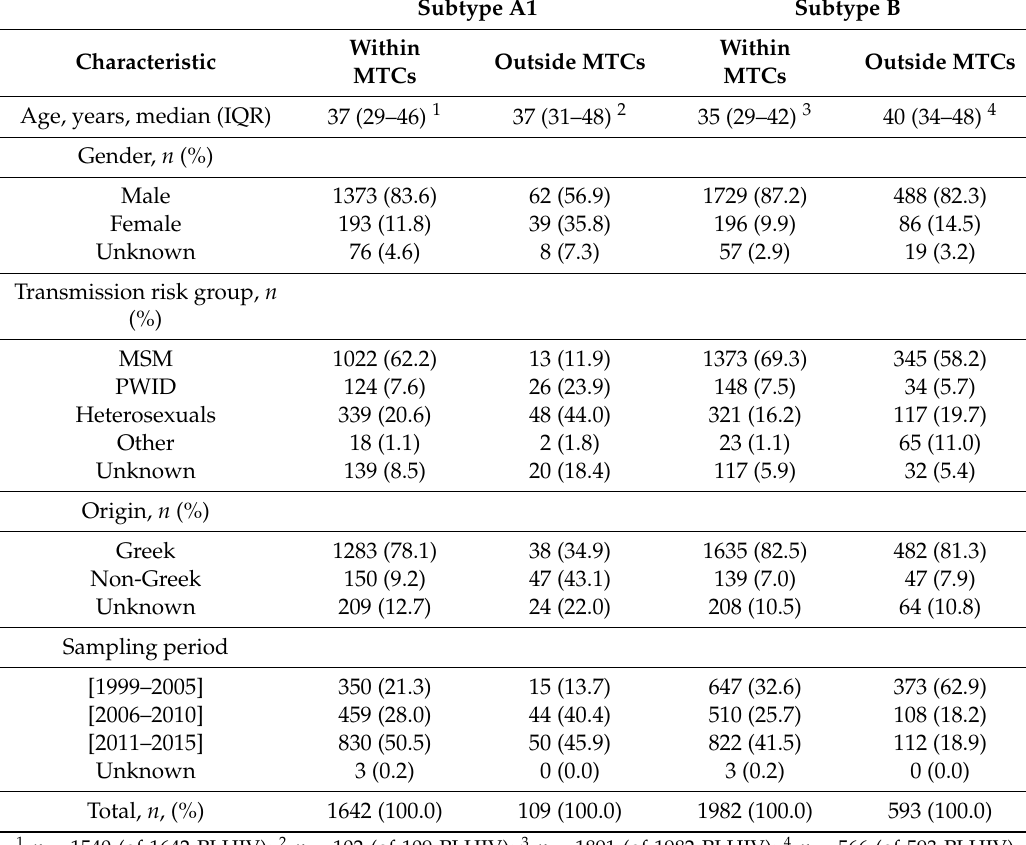
Table 2. Demographic characteristics of PLHIV who were infected with subtypes A1 and B within and outside molecular transmission clusters